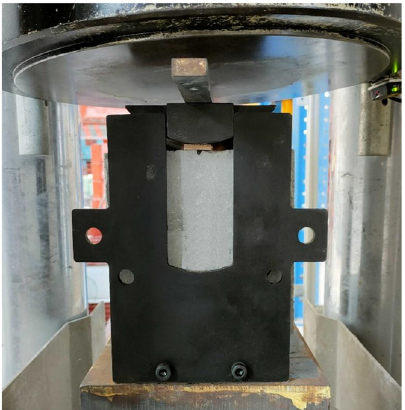
Figure 5: Photograph of the split tensile